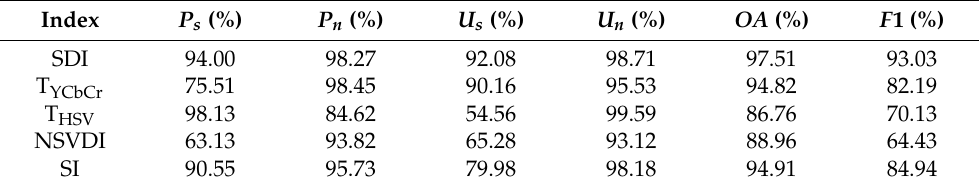
Table 2. Objective evaluation results of shadow detection in study case 2.